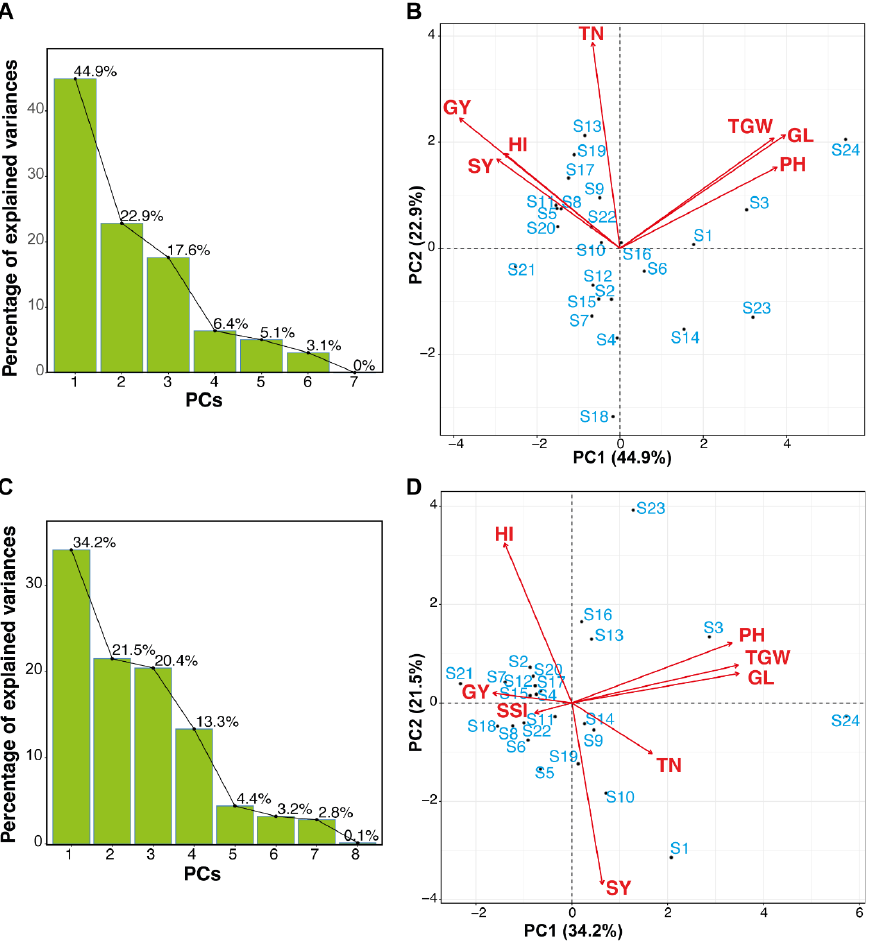
Figure 6. PCA of yield and yield-related traits of rice genotypes. Rice genotypes were evaluated at control ( A , B ) and salinity stress ( C , D ) under field conditions. Scree plots of control ( A ), salinity ( C ) showing significant PCs. First two PCs of control ( B ) and salt stress ( D ). PH = plant height (cm); TN = tillers number; GY = grain yield/plant (g); SY = straw yield (g); TGW = 1000-grain weight (g); GL = grain length (mm); HI = harvest index (%).